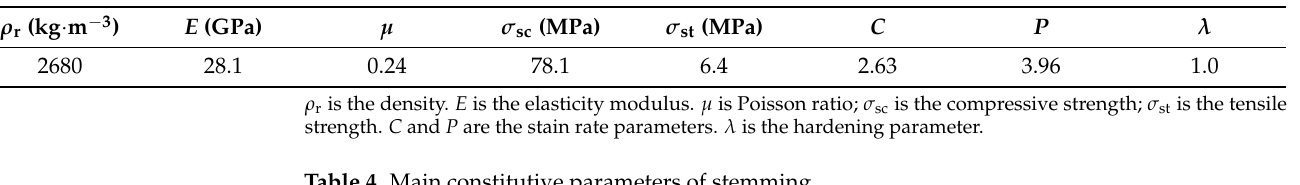
Table 3. Main constitutive parameters of rock.